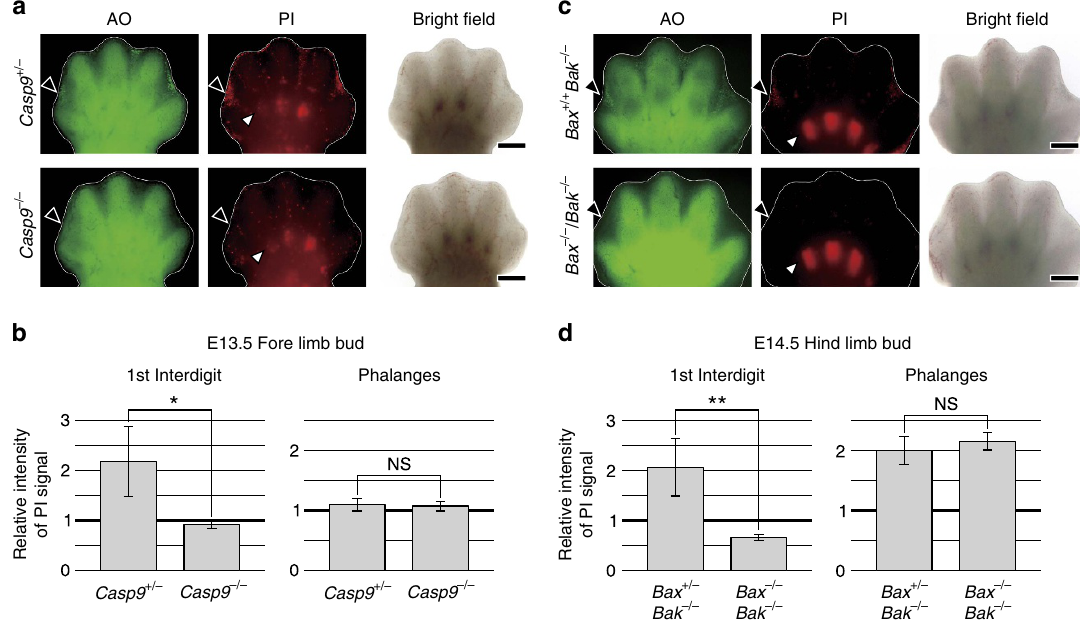
Figure 2 | AO and PI foci in apoptosis-deficient mice. ( a ) Lack of AO and PI foci in the interdigital regions of caspase-9 KO embryos. At E13.5, a caspase-9 KO ( Casp9 (cid:2) / (cid:2) ) embryo and a control ( Casp9 þ / (cid:2) ) embryo were injected with AO and PI, after which the right forelimb buds were observed by fluorescence stereomicroscopy. The first interdigital regions and phalanges are indicated by black and white arrowheads, respectively. Scale bar, 400 m m. ( b ) Bar graphs show quantitative assessment of PI signals in the first interdigital region and phalanges. Left: The relative intensity of PI signals in the first interdigital region was calculated as the PI signals in the region divided by background PI signals in the second digit (see Supplementary Fig. 1a). Data are represented as the mean ± s.d.; n ¼ 9 for Casp9 þ / (cid:2) embryos and n ¼ 3 for Casp9 (cid:2) / (cid:2) embryos. * P ¼ 0.014 for comparison between Casp9 (cid:2) / (cid:2) and Casp9 þ / (cid:2) embryos by the two-tailed Student’s t -test. Right: The relative intensity of PI signals in the phalangeal area was calculated as the PI signals in that area divided by the PI signals in the palmar region (see Supplementary Fig. 1b). Data are represented as the mean ± s.d.; n ¼ 9 for Casp9 þ / (cid:2) embryos and n ¼ 3 for Casp9 (cid:2) / (cid:2) embryos. NS: P ¼ 0.776 for comparison between Casp9 (cid:2) / (cid:2) and Casp9 þ / (cid:2) embryos. Note that PI signals in the phalangeal area were weaker at E13.5 than at E14.5. ( c ). Lack of AO and PI foci in the interdigital regions of Bax / Bak double KO embryos. At E14.5, a Bax / Bak double KO ( Bax (cid:2) / (cid:2) / Bak (cid:2) / (cid:2) ) embryo and a control ( Bax þ / þ / Bak (cid:2) / (cid:2) ) embryo were injected with AO and PI, and the right hind limb buds were observed. ( d ) Bar graphs show quantitative assessment of PI signals in the first interdigital region and the phalanges. Data are represented as the mean ± s.d.; n ¼ 6 for Bax þ / (cid:2) / Bak (cid:2) / (cid:2) embryos and n ¼ 4 for Bax (cid:2) / (cid:2) / Bak (cid:2) / (cid:2) embryos. ** P ¼ 0.0014, NS: P ¼ 0.288 for comparison between Bax (cid:2) / (cid:2) / Bak (cid:2) / (cid:2) and Bax þ / (cid:2) / Bak (cid:2) / (cid:2) embryos by the two-tailed Student’s t